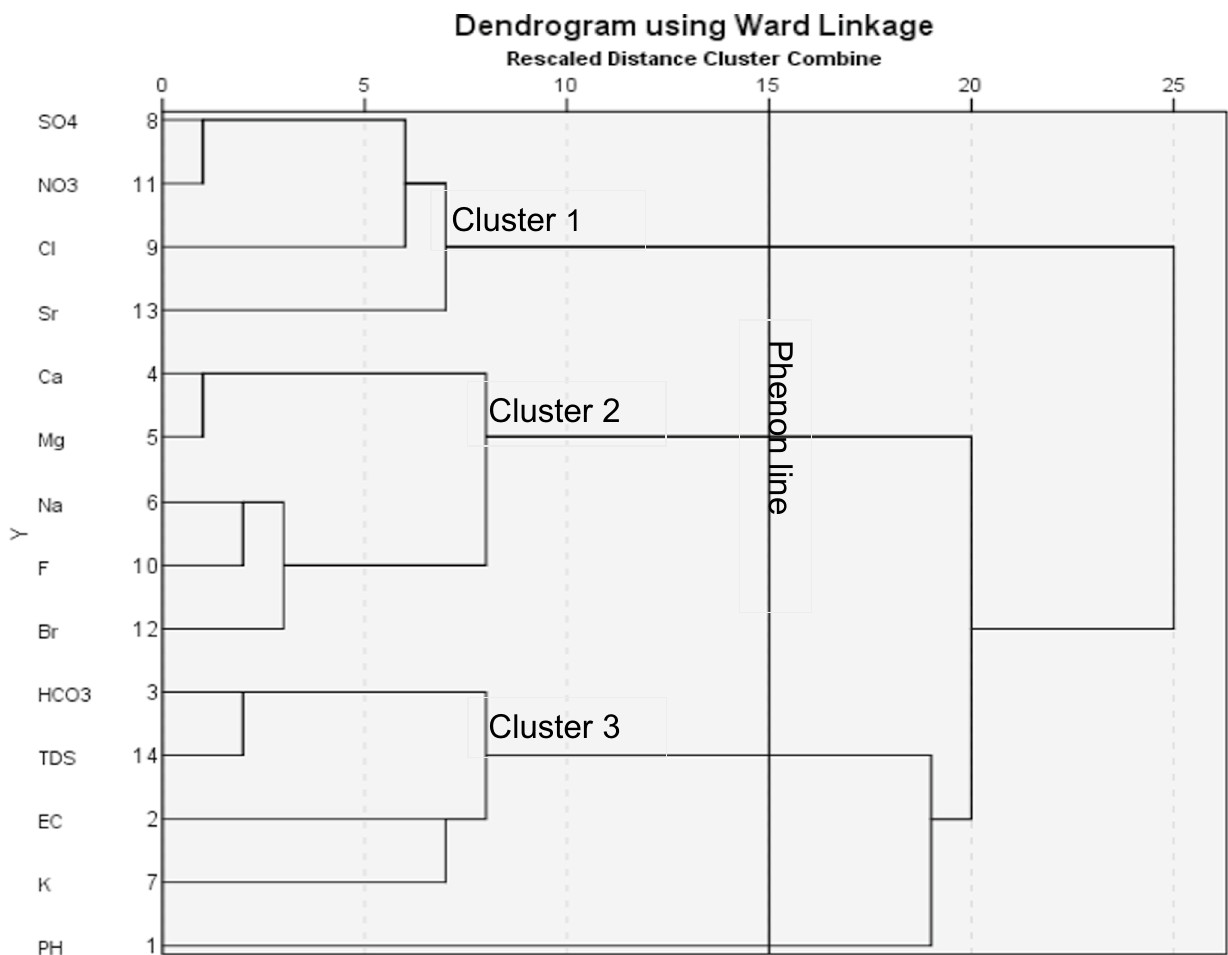
Fig. 5 Dendrogram showing R-mode